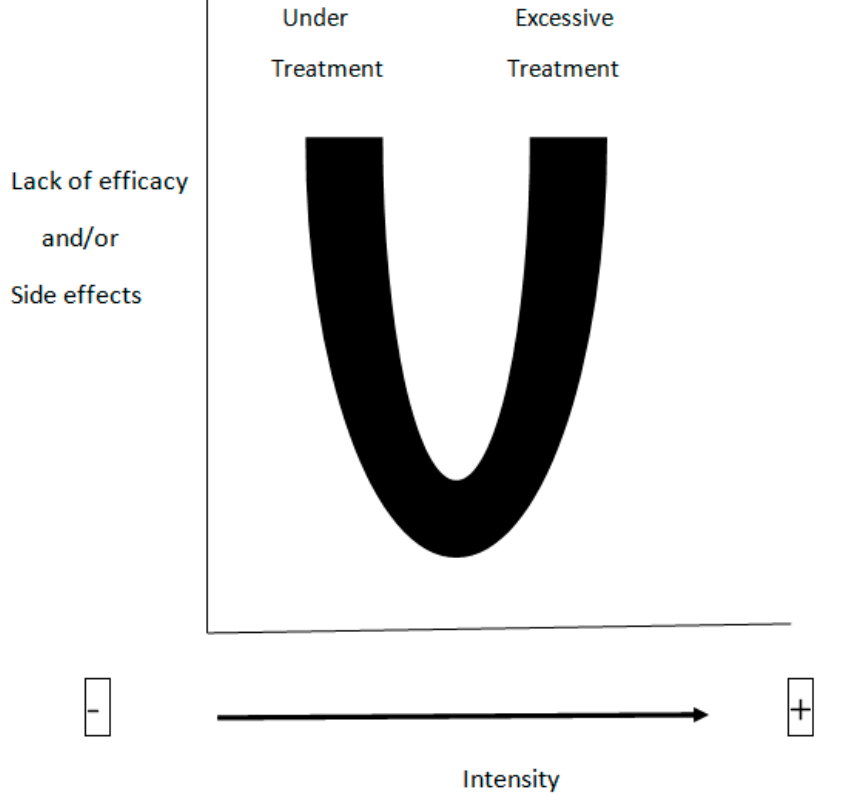
Figure 2. Hypothetical dose–effect relationship between the intensity of the treatment and the occurrence of side effects.